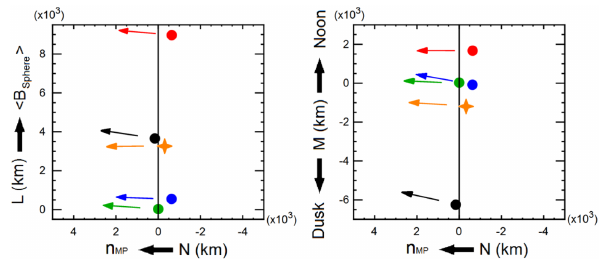
Figure 4. Motion of the magnetopause boundary: the projection of Cluster spacecraft positions onto the LN and MN planes, in stan- dard code coloured filled circles (as in Fig. 1), for the time just be- fore crossing the magnetopause. The model magnetopause bound- ary is shown as vertical lines. For each spacecraft there is an ar- row representing the direction of normal vector calculated using the MVAB method; the four-spacecraft timing analysis is shown as or- ange arrows, where the four-spacecraft timing analysis velocity is (0.53, − 2.88, − 43.82) in LMN. (See Sect. 4.3 for details.)